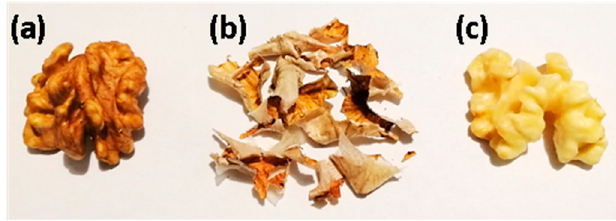
Figure 2. ( a ) Kernel; ( b ) pellicle; ( c ) kernel without the